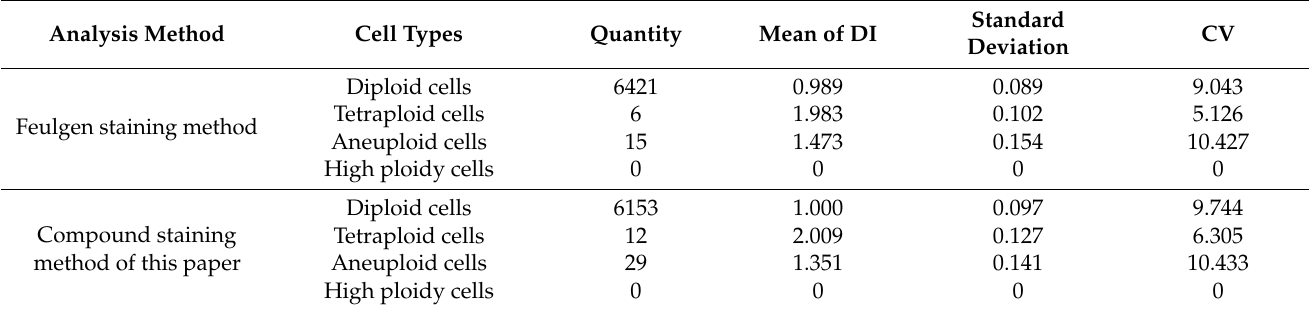
Figure 8. The analysis results of negative case; ( a ) the results of Feulgen staining method, ( b ) the results of compound staining method. Table 1. Contrast data of negative